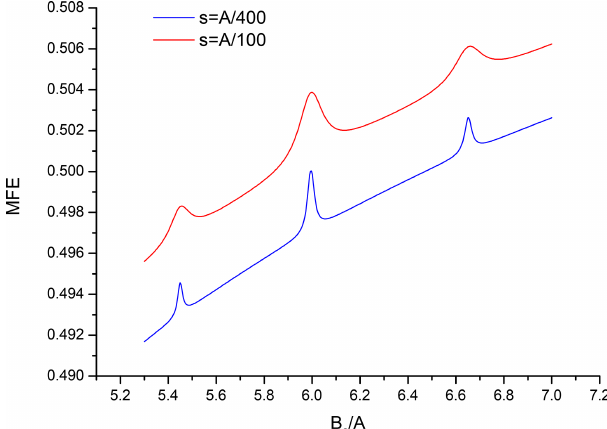
Figure 3. Closeup of the spectrum from Fig. 1 in the vicinity of B 0 = 6 A for two values of the recombination parameter s = A/ 100, s = A/